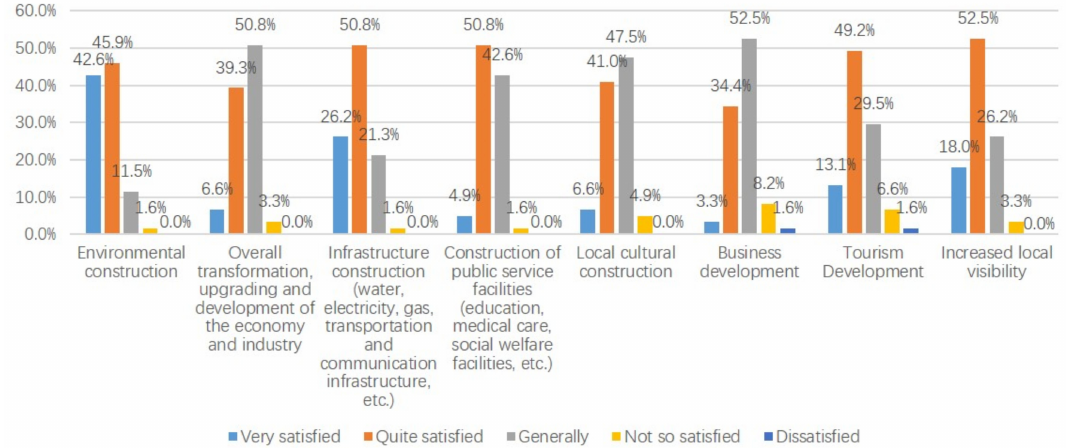
Figure 36. Respondents’ satisfaction with the local CT practice to promote local development (WLLTT) (source: